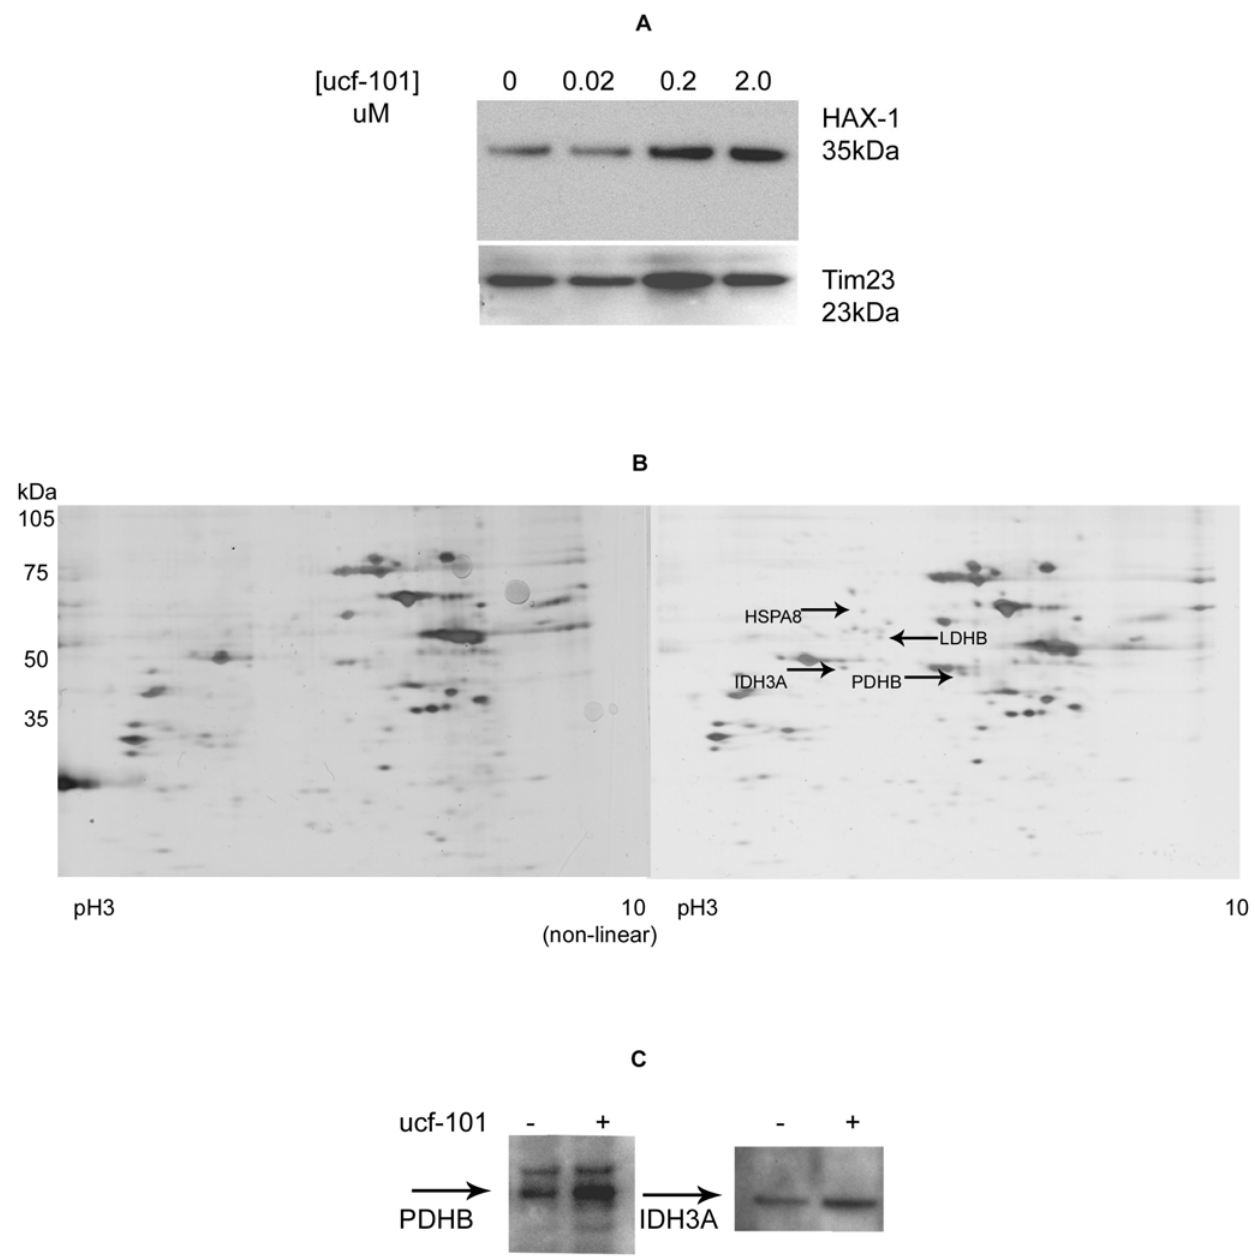
Figure 1. Inhibition of HAX-1 degradation by native OMI in HEK293 cells. (A) Immunoblot of mitochondrial proteins showing increased persistence of HAX-1 with increased concentration of the OMI inhibitor ucf-101. (TIM23 is shown as a loading control). (B) Silver stained IEF/2D gel of mitochondrial proteins present after isolated mitochondrial samples were divided into two equal parts and incubated in the presence or absence of ucf-101. Arrows indicate species that persisted when the inhibitor ucf-101 was included. (C) Immunoblot of mitochondrial samples validating the increased persistence of PDHB and IDH3A in the presence ( + ) of ucf-101.